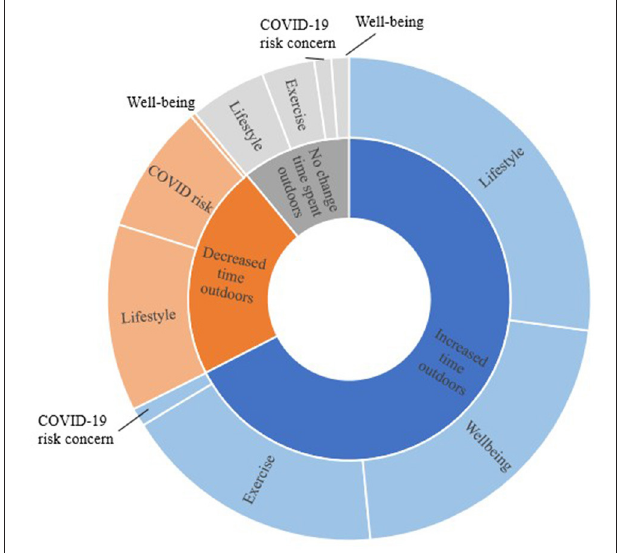
FIGURE 2 | What motivation did participants report for changing their time spent outdoors? Percentage of the motivation participants reported for increased time outdoors, decreased time outdoors, or no change spent outdoors from March 25 to April 3rd, 2020.